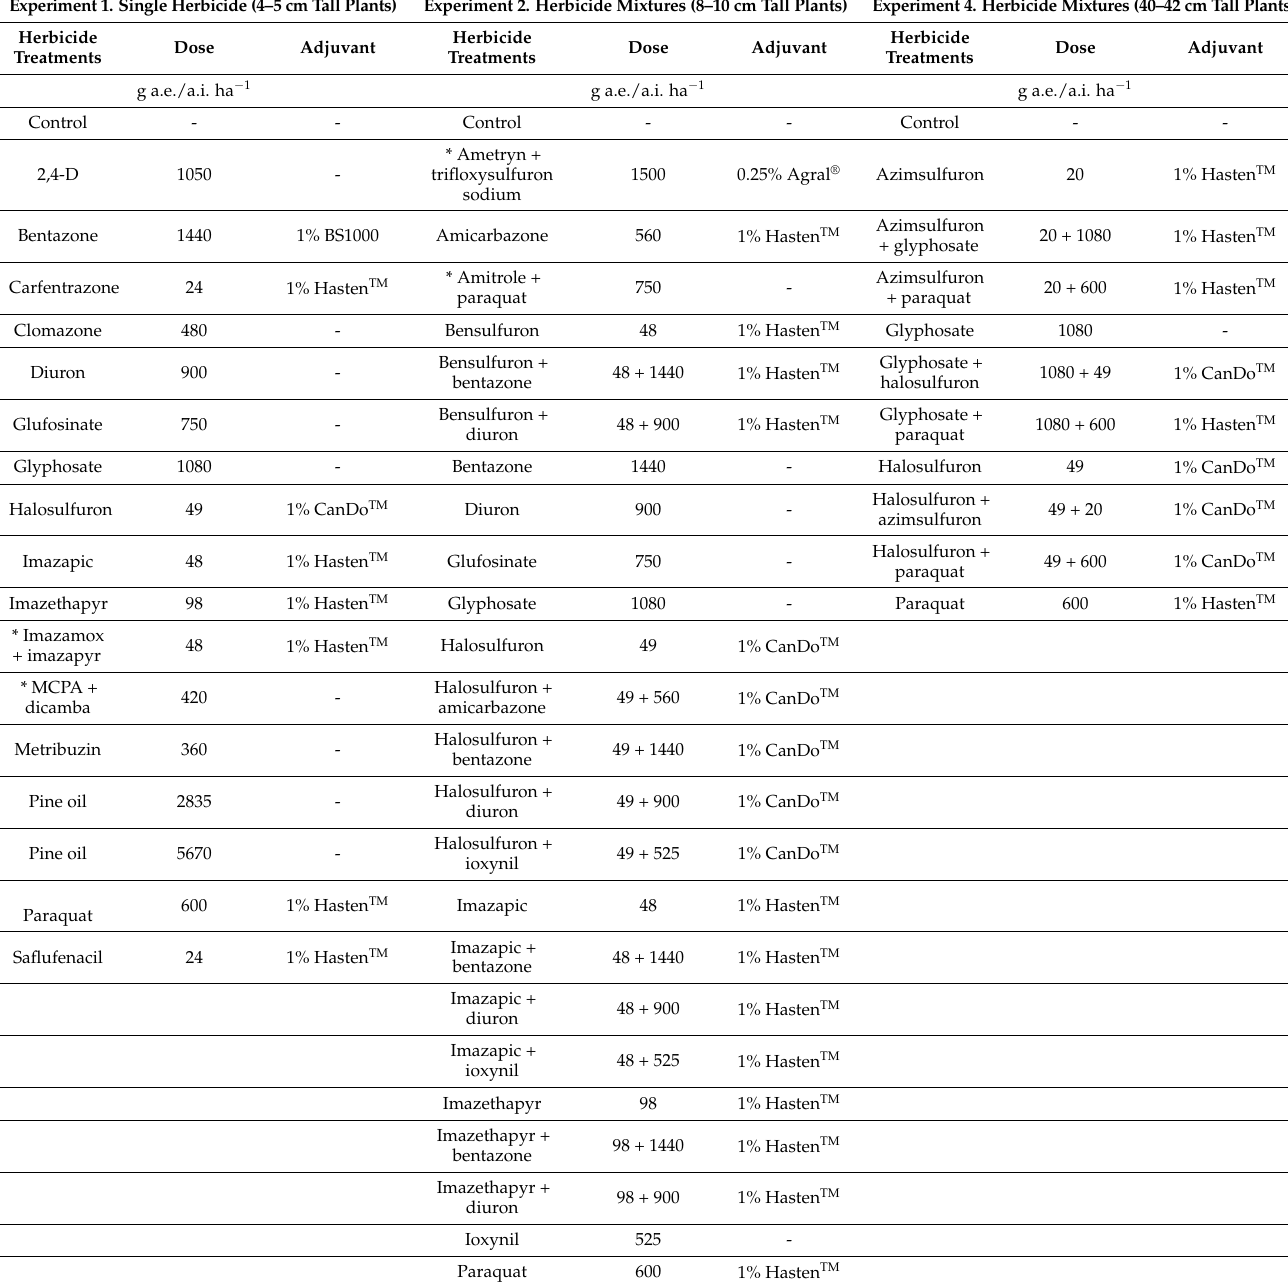
Table 1. Herbicides, their doses, and adjuvants used in Experiment 1, 2, and 4. Experiment 1. Single Herbicide (4–5 cm Tall